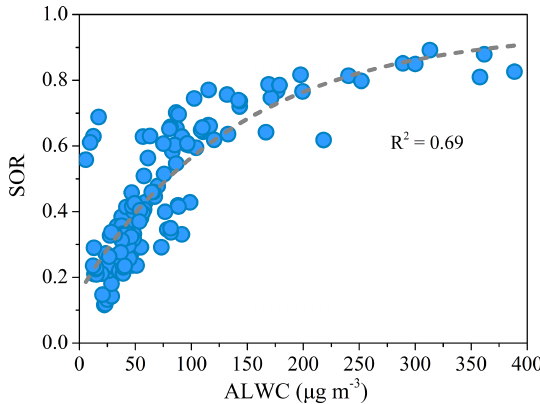
Figure 6. The relationship between SO 2 − (RH<50%) and high-RH (RH>50%) pollution episodes.